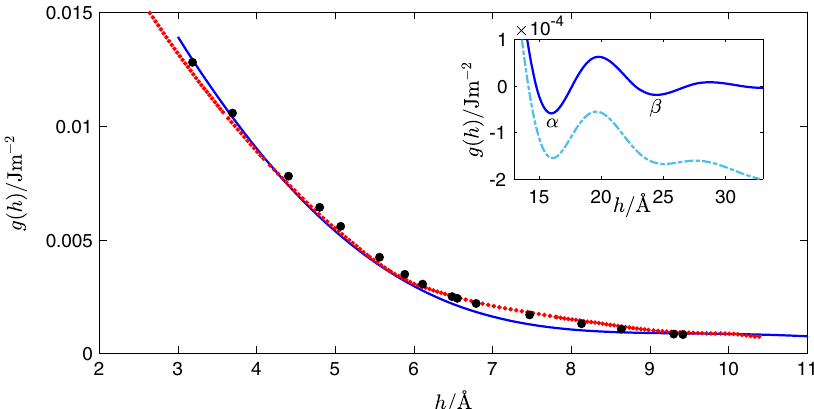
Fig. 1 Interface potential for a water fi lm adsorbed on ice as calculated from computer simulations. The small red circles are simulation results obtained from this work. The larger black circles are results obtained by integration of the related disjoining pressure as determined recently 41 . The dark solid blue line is a fi t to the simulation results, constrained to exhibit two minima. The inset shows details of the primary α and secondary β minima, which are not visible on the scale of the main fi gure. For an inert substrate, the β state is stabilized at pressures Δ p = 46,000Pa above liquid – vapor saturation (dot- dashed light-blue